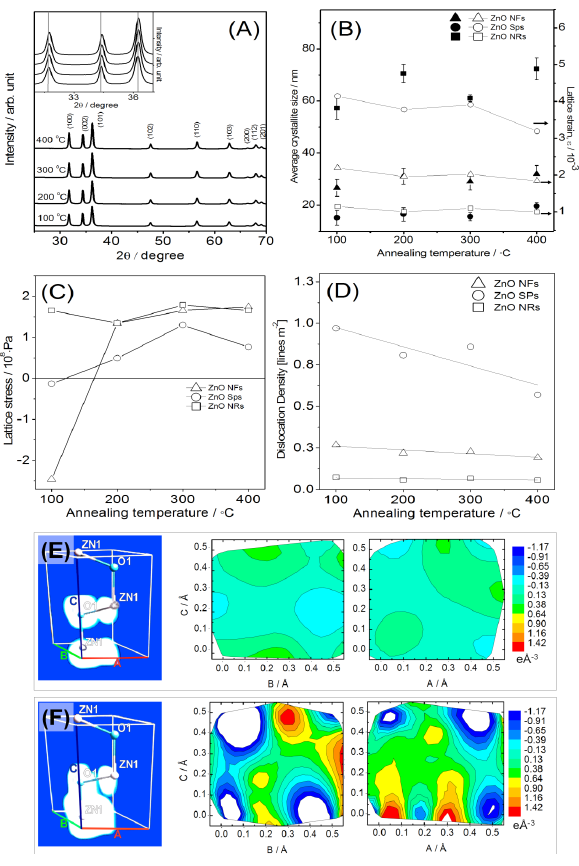
Figure 5: (A) XRD patterns of ZnO NFs measured at diffraction angles (2 θ ) between 27.5 and 70 o , (B) average crystallite size and lattice strain of ZnO nanostructures, (C) lattice stress and (D) dislocation density of ZnO at different annealing temperatures, and electron density map of ZnO NFs annealed at (E) 200 and (F) 300 °C. XRD patterns of ZnO SPs and ZnO NRs can be found in Supporting Information. Enlarged figures inserted in the XRD pattern (Fig. 5A) shows the three highest intensities at crystal plane (1 0 0), (0 0 2) and (1 0 1) compared to the references (dashed